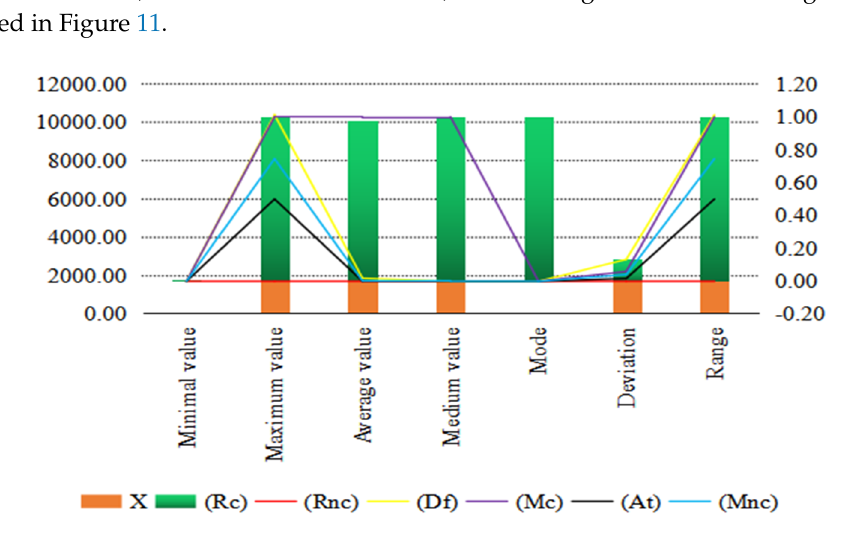
Figure 11. Analyses all of rational nodes when choosing defender strategies.